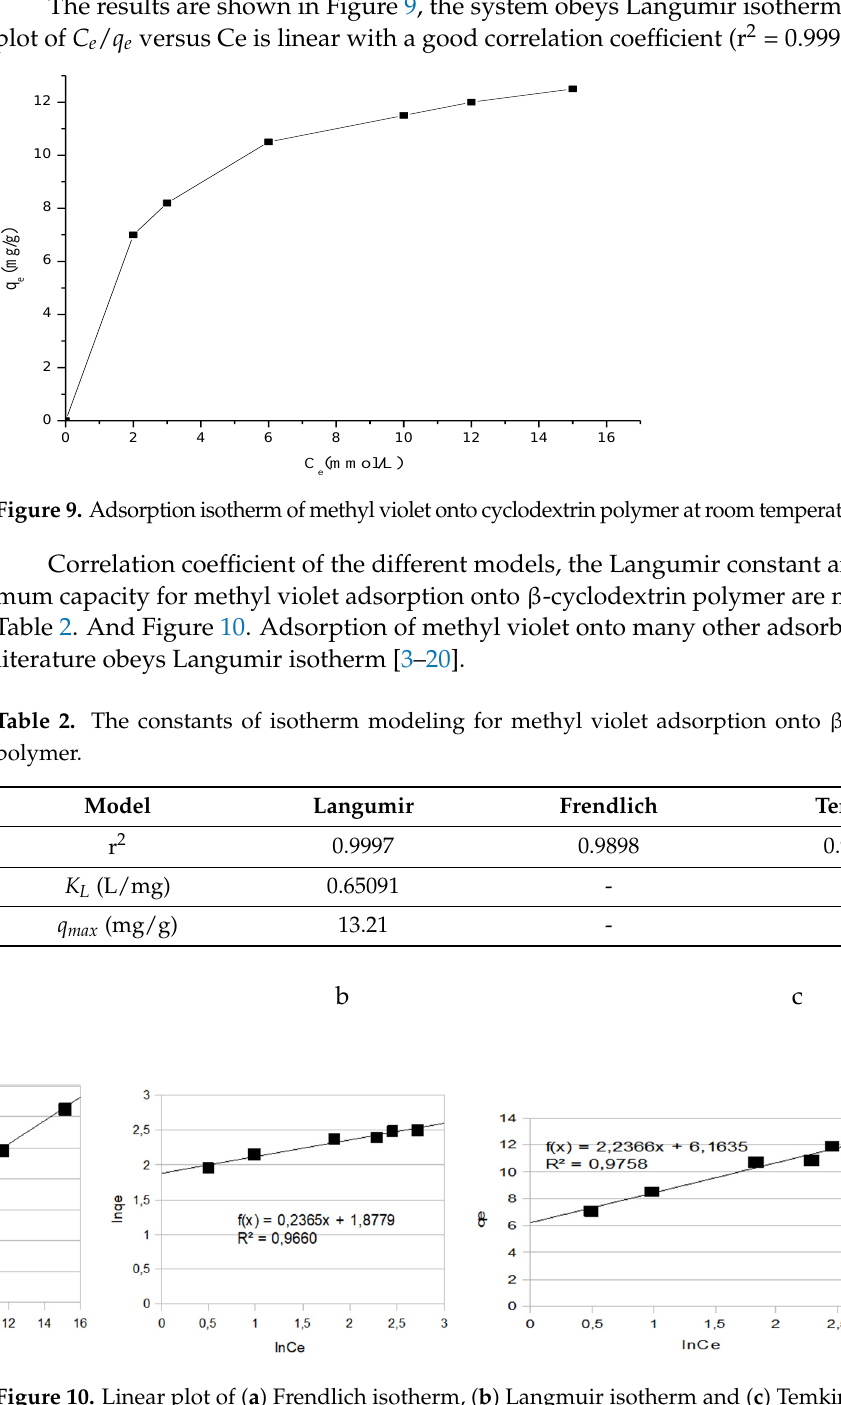
Figure 10. Linear plot of ( a ) Frendlich isotherm, ( b ) Langmuir isotherm and ( c ) Temkin isotherm for methyl violet onto β -cyclodextrin polymer.